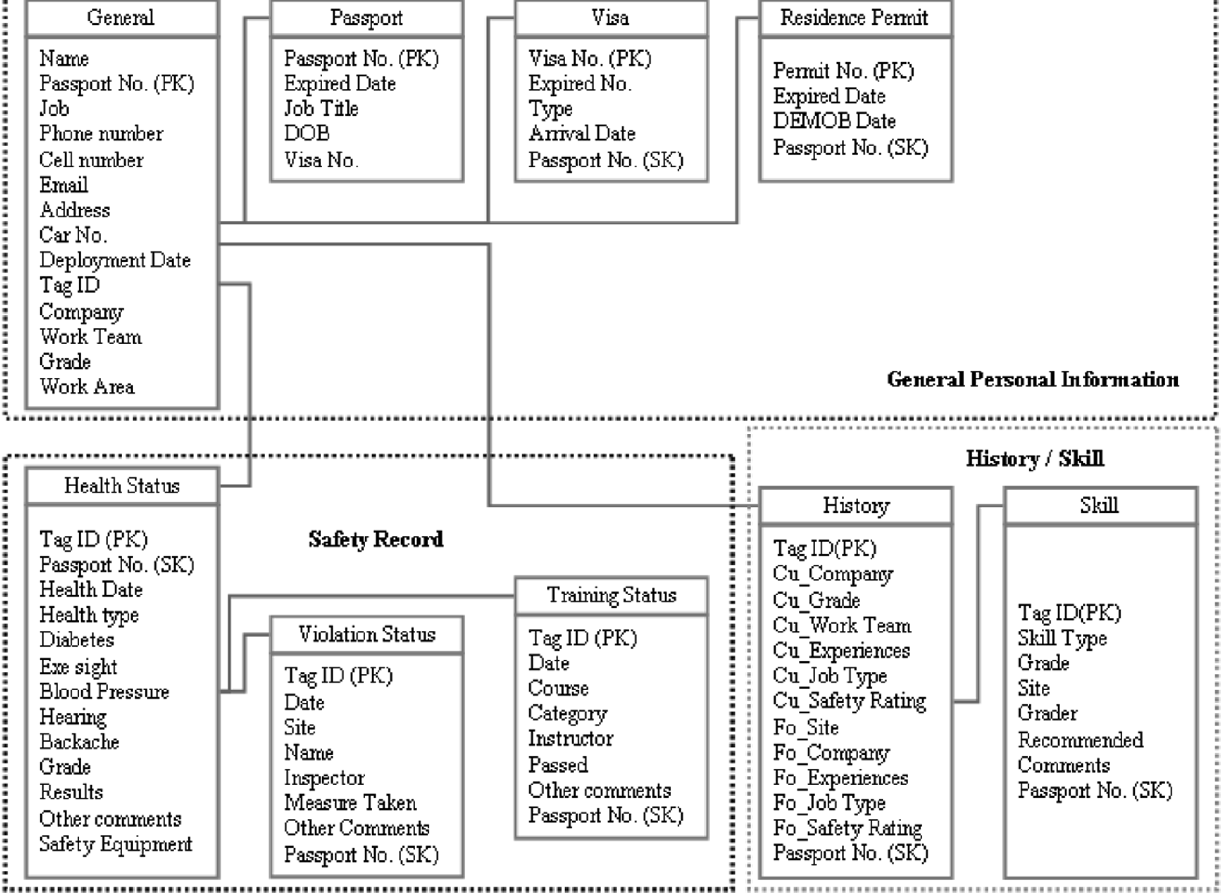
Fig. 4. Entity relation diagram for Workforce Information Database